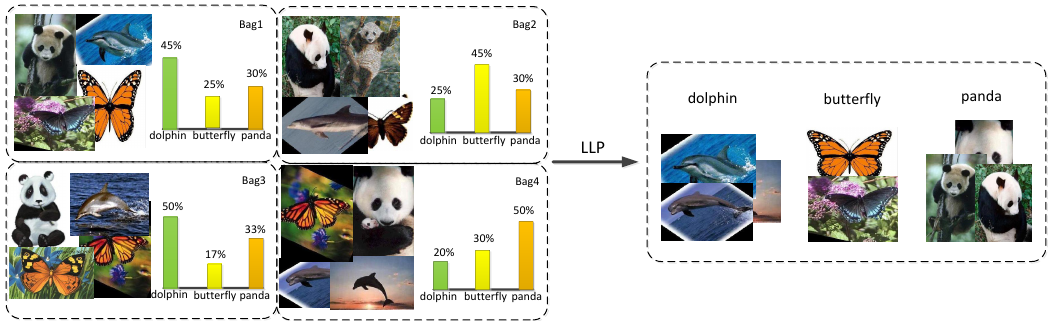
Figure 1. The illustration of multi-class learning from class proportions. In detail, there are images of three categories including pandas, butterflies and dolphins and they are divided into four bags with no intersection among them. In each bag, the amount of different categories is denoted by the sizes of rectangles with different colors respectively and a proportion information can be obtained by the sizes of different categories. Then a multi-classifier could be obtained by learning from label proportions. On the right pandas, butterflies and dolphins are separated according to the